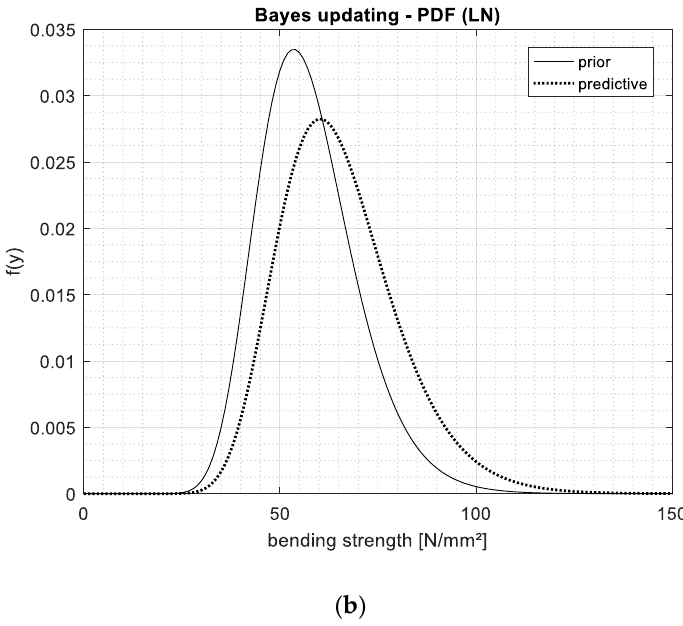
Figure 6. Bayes updating: ( a ) the cumulative distribution function; ( b ) the probability density function The expected value of the predictive material model is higher than that of the prior model. The coefficient of variation is also slightly higher, as within the updating procedure the uncertainties resulting from the original (prior) model and the test results are coupled. The predictive distribution function may be used to verify the load-bearing capacity of the member within a probabilistic evaluation (KL 3).